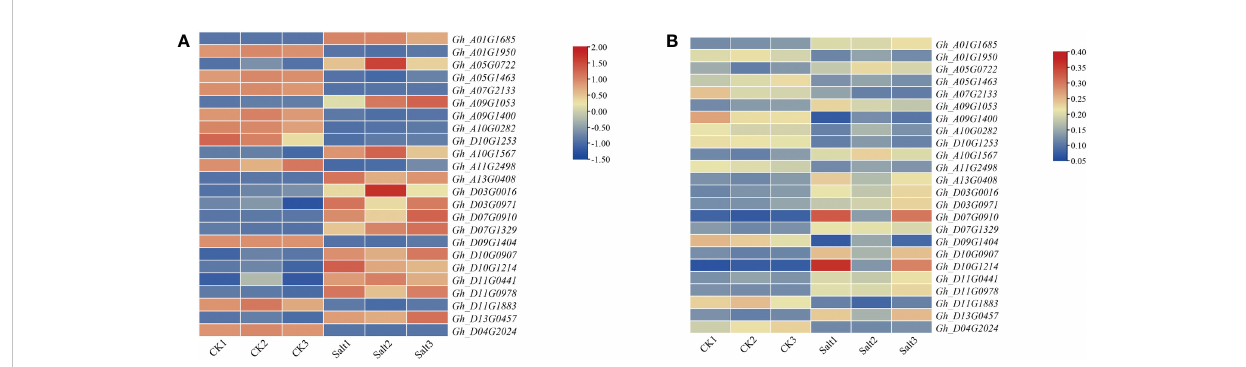
FIGURE 1 Expression pro fi les of candidate genes and proteins under salt stress. (A) Expression pro fi les of candidate genes under salt stress. (B) Expression pro fi les of proteins encoded by candidate genes under salt stress. The abscissa in the fi gure is the sample name, the ordinate is the gene name, and different colors represent different expression values.